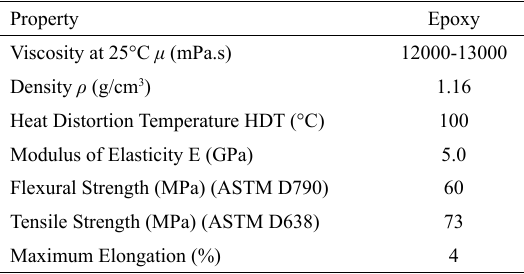
Table 1. Properties of Epoxy resin at room temperature.